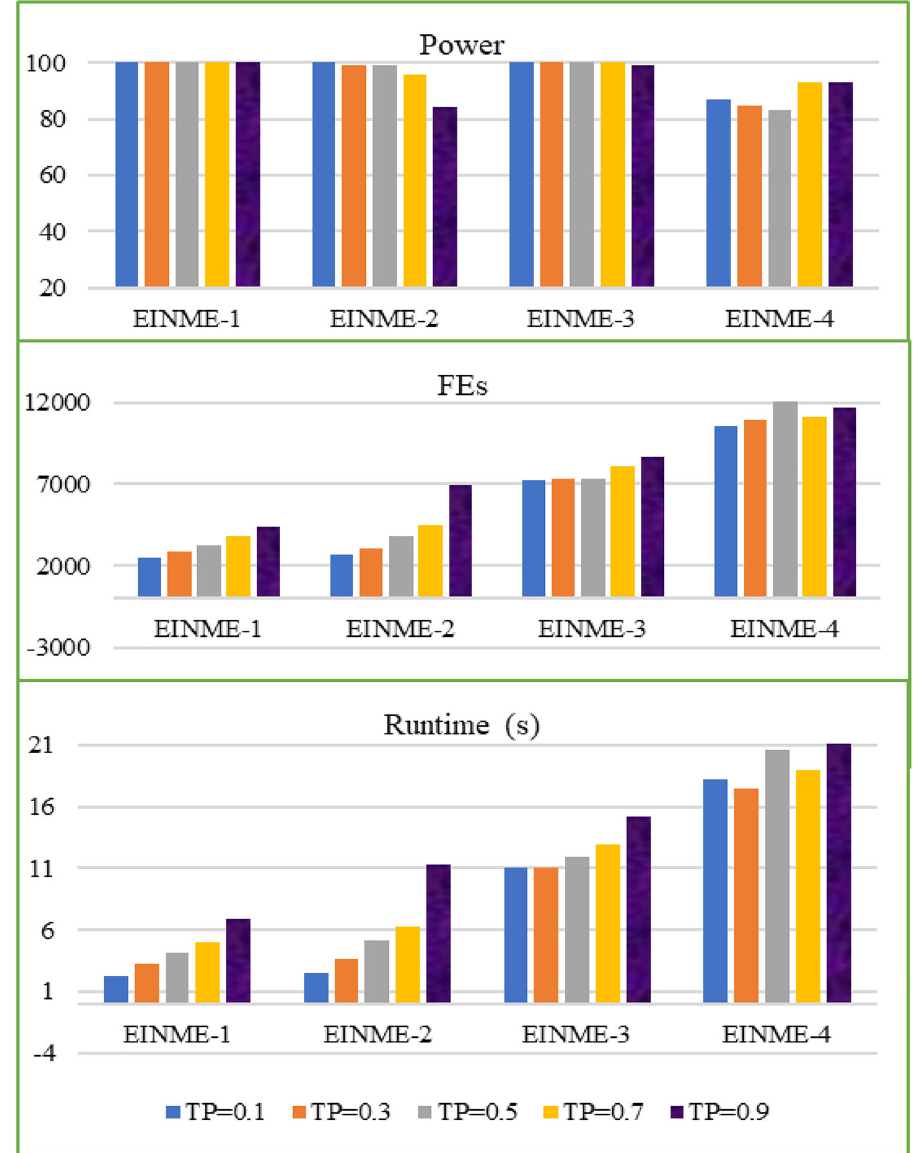
Fig. 3 Effect of TP on the performance of MTHSA-DHEI for detecting EINME